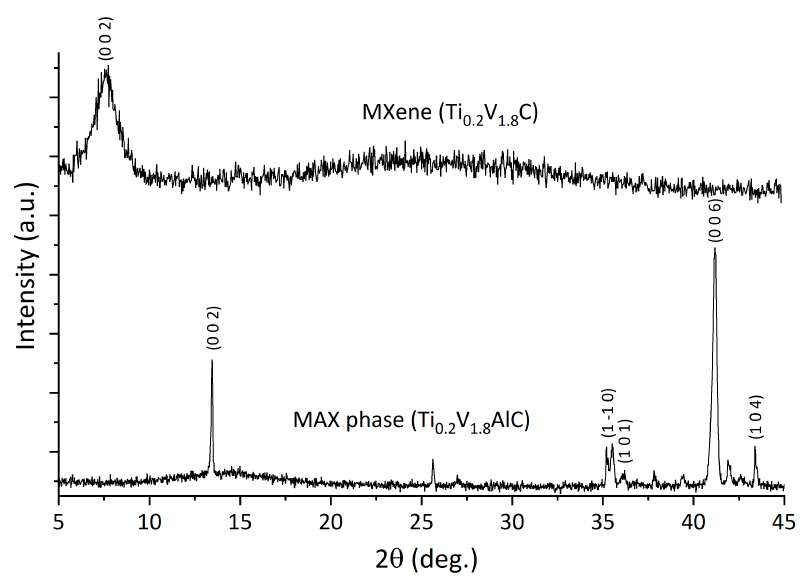
Figure 3. XRD patterns of the synthesized Ti 0.2 V 1.8 AlC MAX phase and Ti 0.2 V 1.8 C MXene samples.